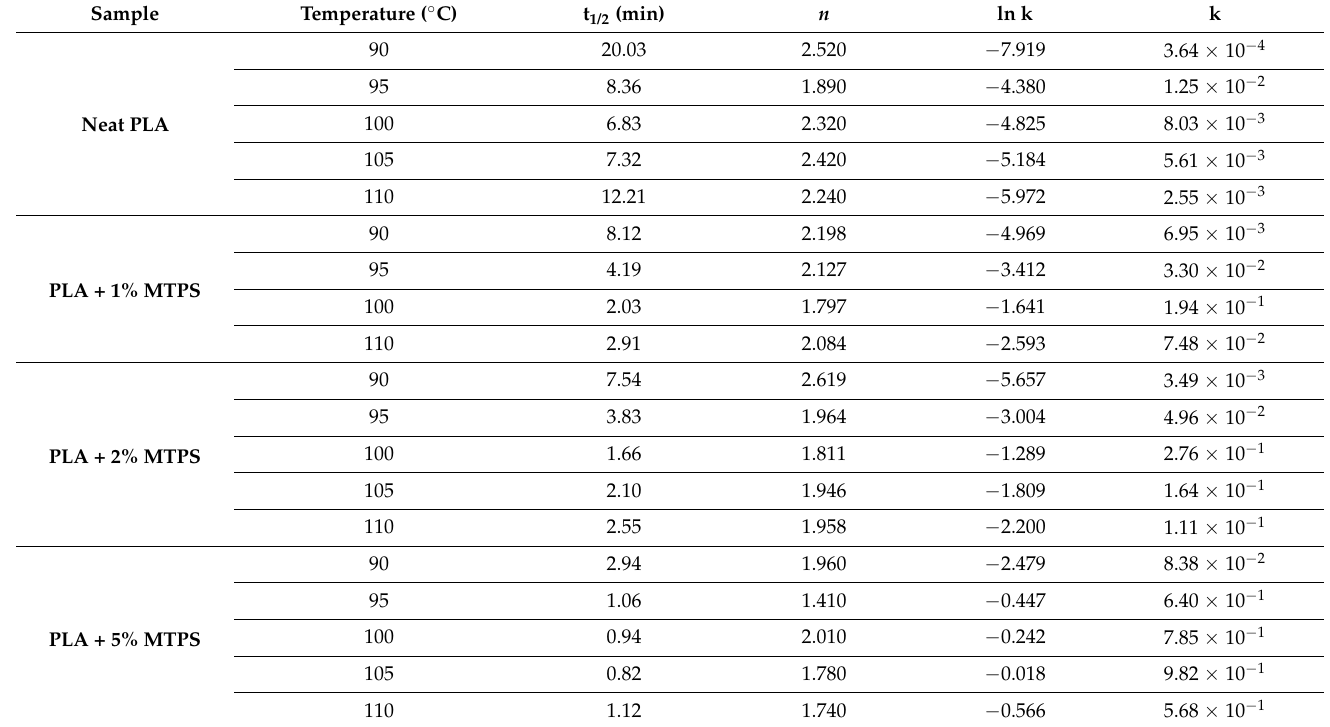
Table 8. Crystallization half times and Avrami constants for PLA samples at different